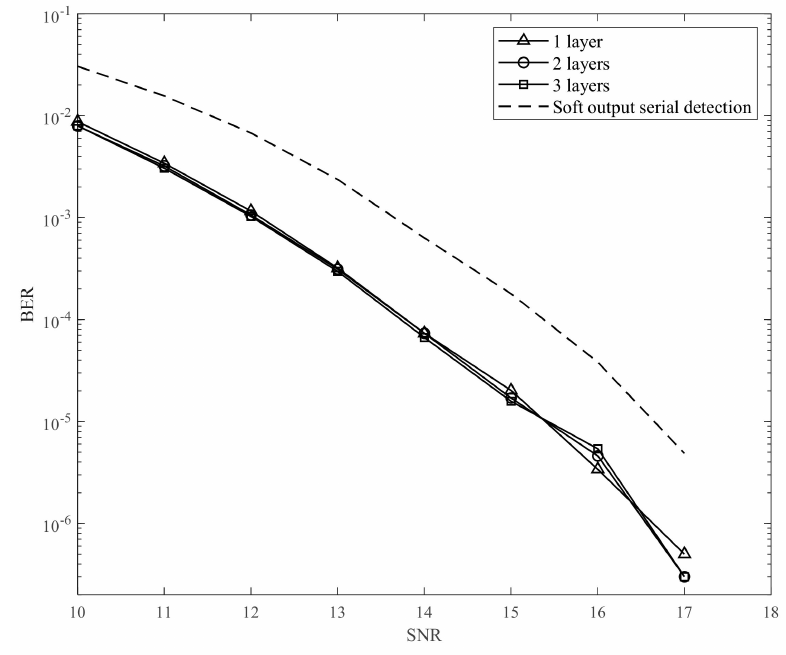
Figure 20. BER versus SNR for 6% position